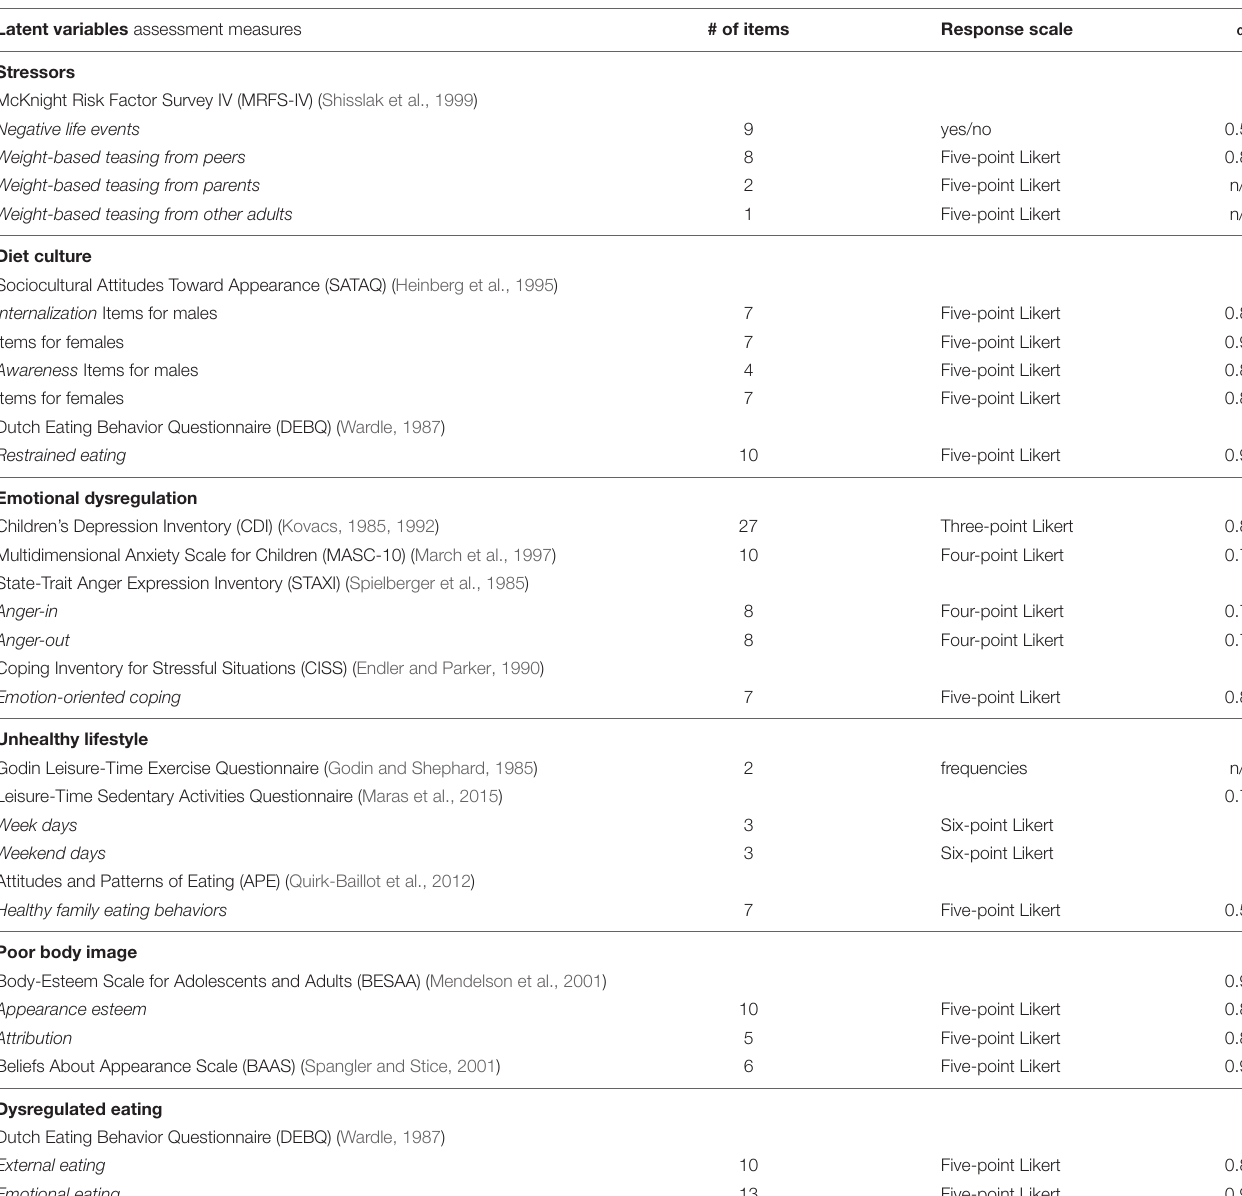
TABLE 1 | Summary of predictor variables, measures, and their psychometric properties in the study